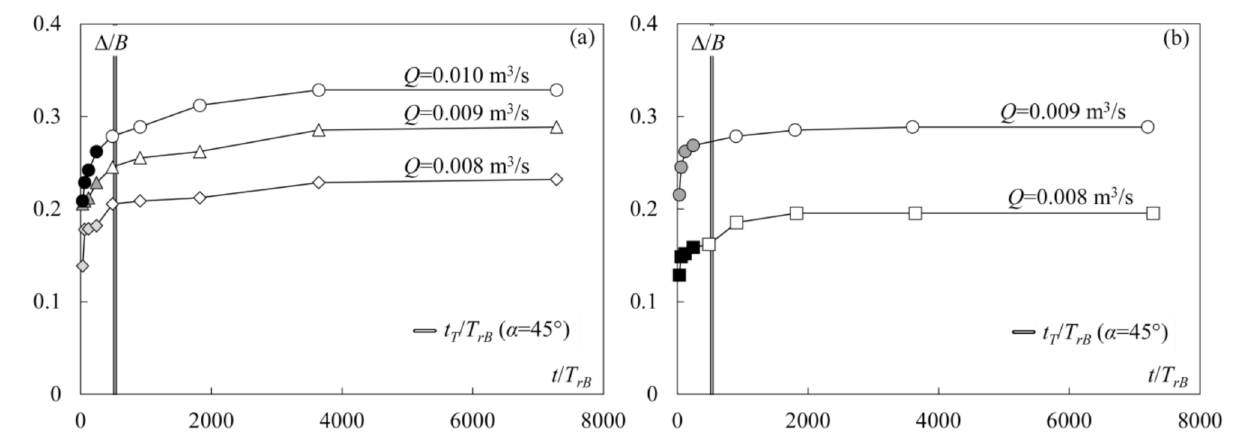
Figure 4. ∆ / B versus t / T rB for ( a ) rock, grade-control structures (data not included in Pagliara and Palermo [7]) and ( b ) stepped gabion weirs tests (Palermo and Pagliara [27]), along with the vertical line indicating the transition time calculated using Equation (3) with α = 45 ◦ . Filled symbols pertain to the developing phase, whereas empty symbols belong to the developed